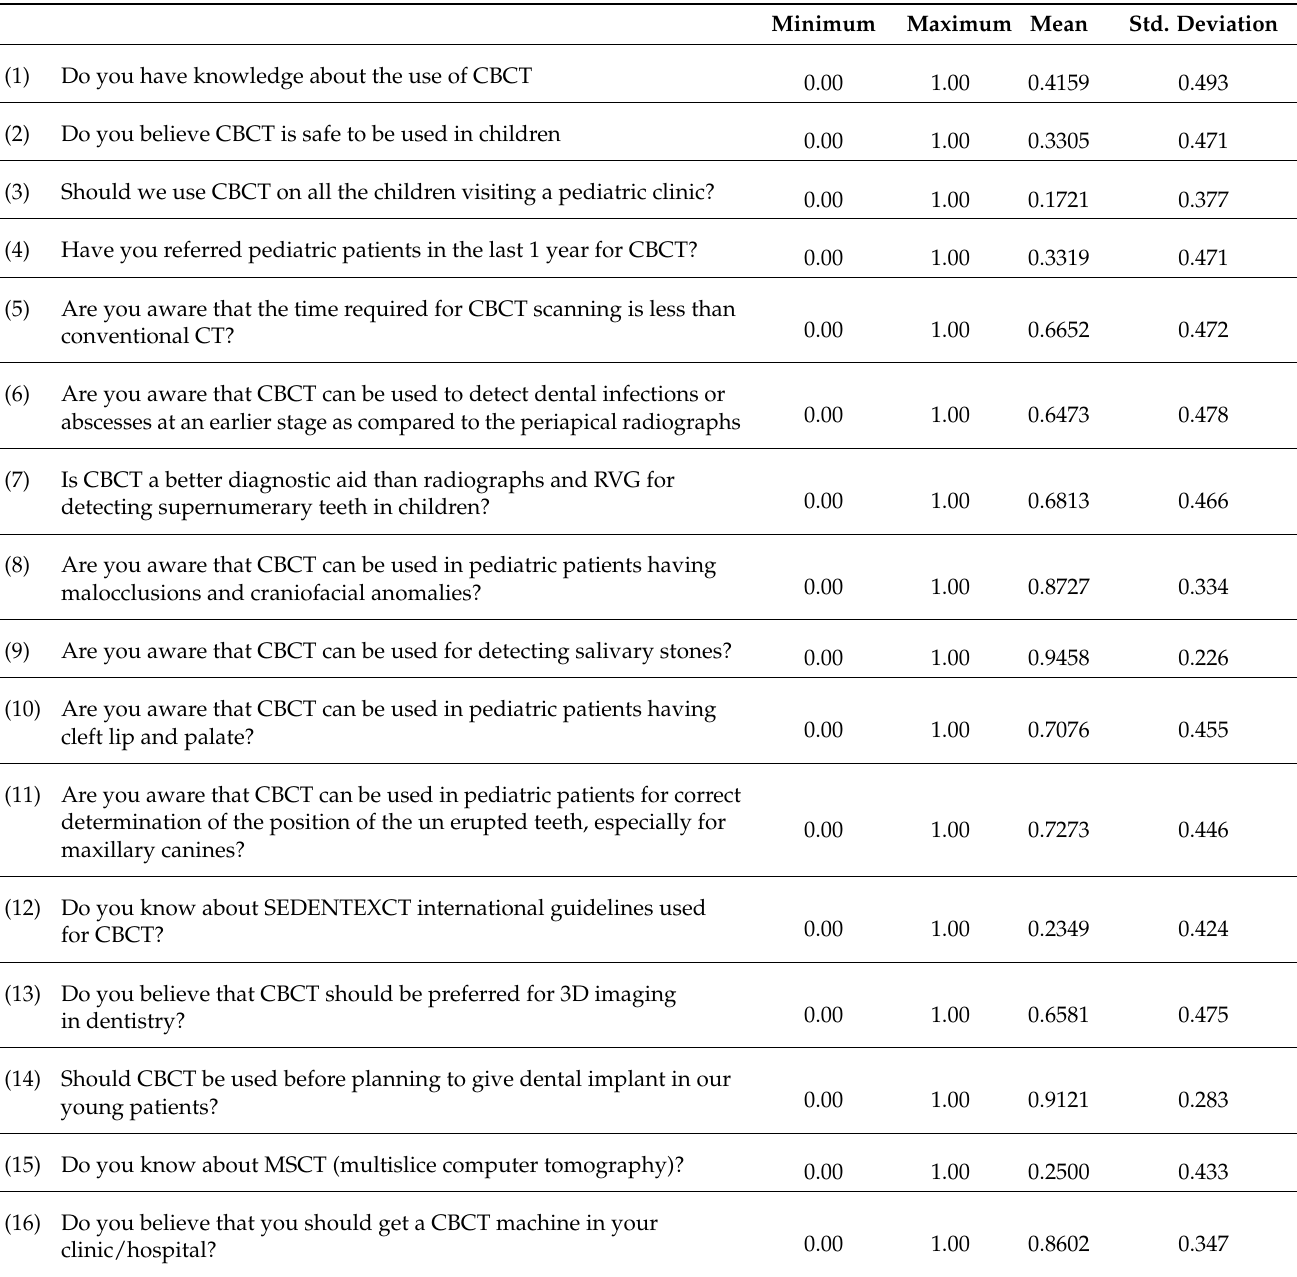
Table 3. Mean Knowledge score regarding